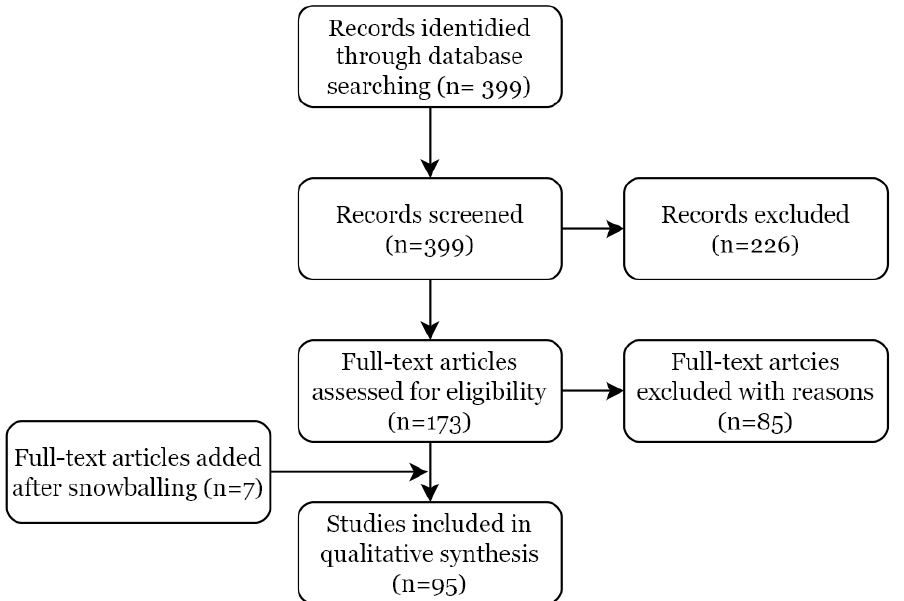
Figure 2. Literature review diagram based on Systematic Reviews and Meta-Analyses (PRISMA) systematic literature review methodology